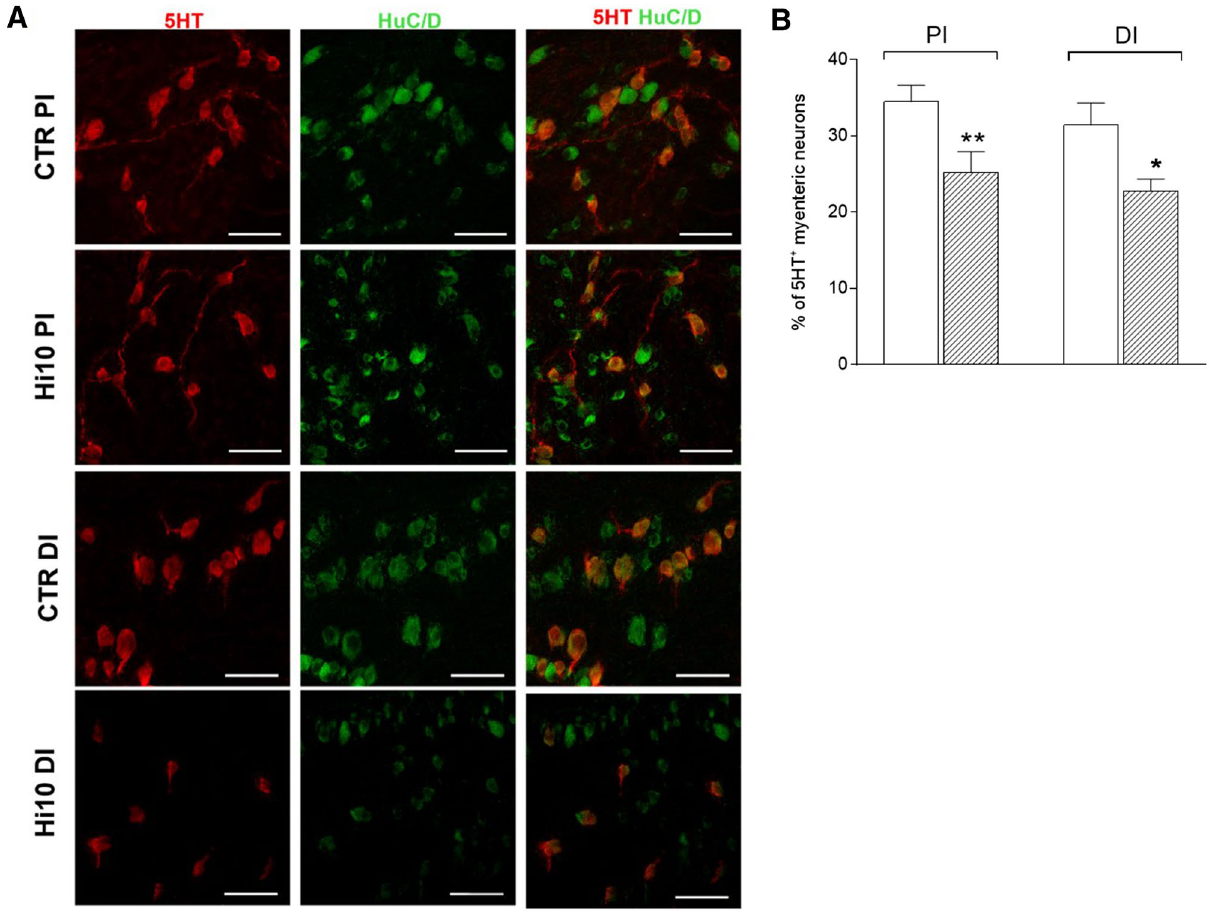
Figure 7. Hermetia illucens meal influences serotoninergic excitatory contractions in the proximal and distal intestine of the gilthead sea bream. ( A ) Immunohistochemical co-localization of 5-HT with the neuronal marker HuC/D in the different experimental groups. 5-HT immunoreactivity was detected in the soma and axon of myenteric neurons. Bars: 50 µm. ( B ) Percentage of 5-HT + neurons in the proximal and distal sea bream intestine obtained from CTRL (empty bar) and Hi10 fed animals (dark upward diagonal bar). Data are reported as mean ± SEM, N = 5 fish/group. Difference significance: * P < 0.05 versus CTRL DI, ** P < 0.01 versus CTRL PI by one-way ANOVA with Sidak’s post-hoc